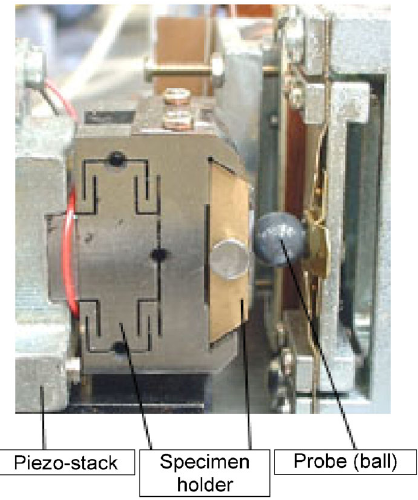
Fig. 4 Photograph of a measure unit realized in CAM